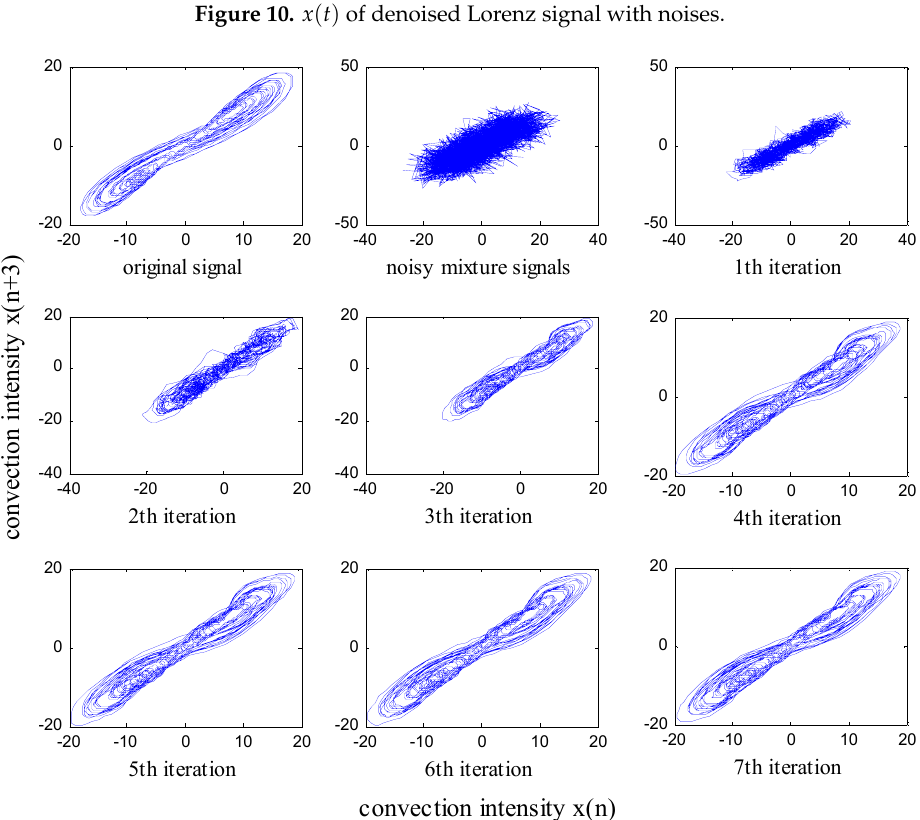
Figure 11. The original signal, superimposed noises signal, and 7 times iteration denoised signal. The SNR, C m , and MSE values change along with iterations, and can be shown in Figures 12–14 respectively.